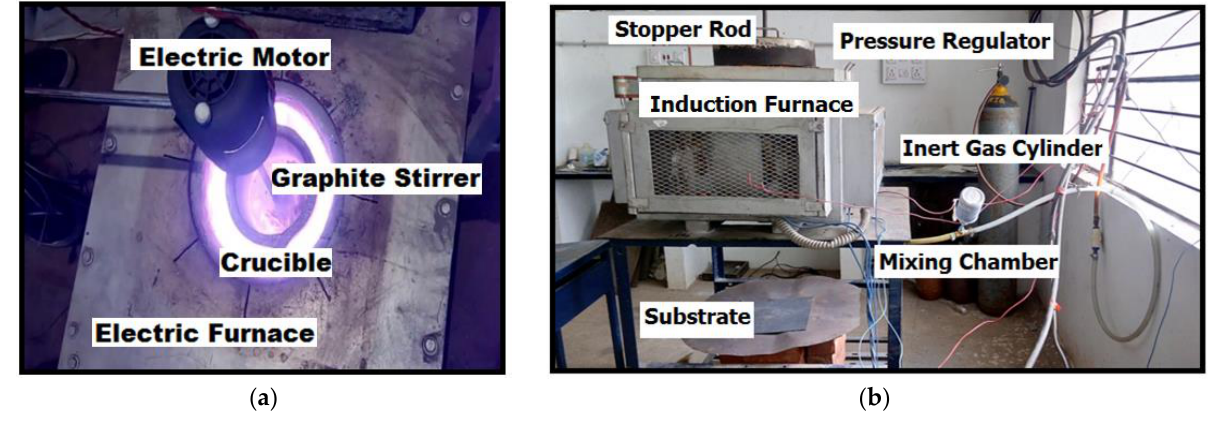
Figure 1. SEM image of Si-Al alloy matrix reinforced with ( a ) 0% ( b ) 5%, ( c ) 10% ( d ) 15 wt.% of ZrO 2 particulates of mean diameter 25 µm.